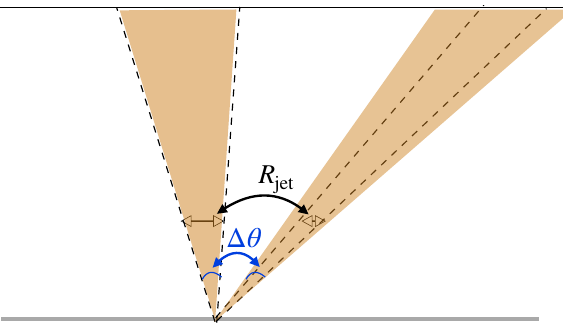
Figure 3 . Illustration of ∆ θ effect for prompt jets. The dashed lines depict jets with the same R jet while the shaded regions depict jets with the same ∆ θ